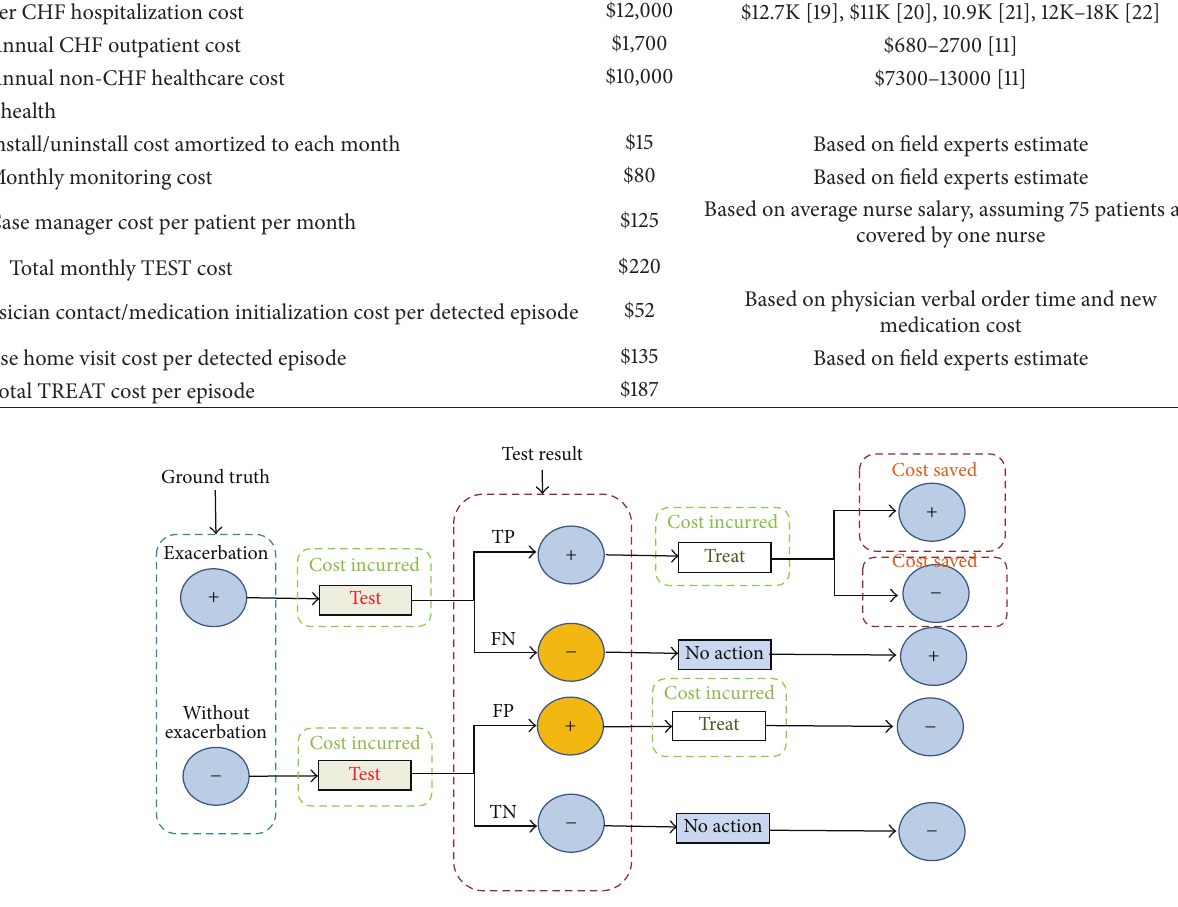
Figure 3: Cost consequences of deploying telehealth programs with certain exacerbation detection sensitivity and specificity. Note that there are two cost saving channels: when true exacerbation (+) is converted to nonexacerbation status ( − ), cost is saved through reverted admission. Evenwhentrueexacerbationisnotreverted,throughtelehealthmonitoringandearlyintervention,theseverityofexacerbationcanbereduced such that even if the patients are admitted to hospital, the length of stay would be